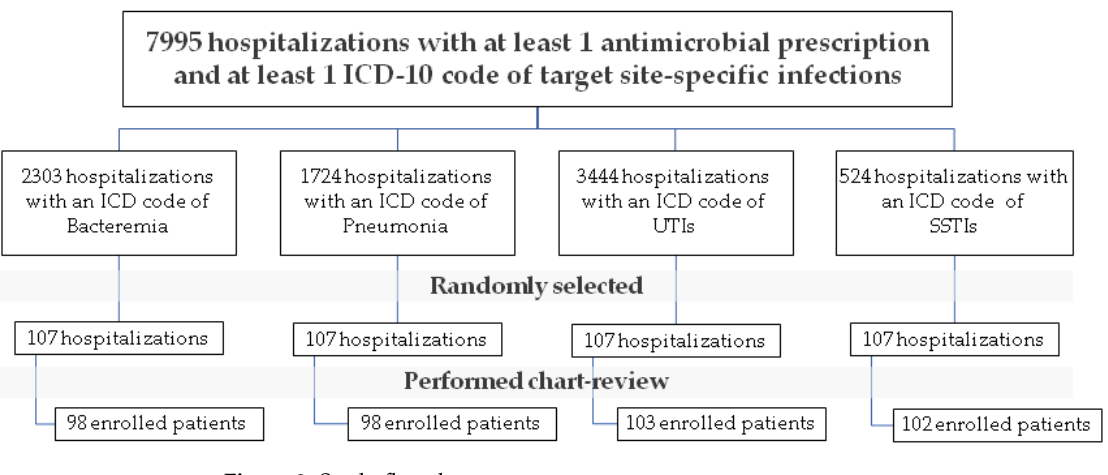
Figure 2. Study flowchart.